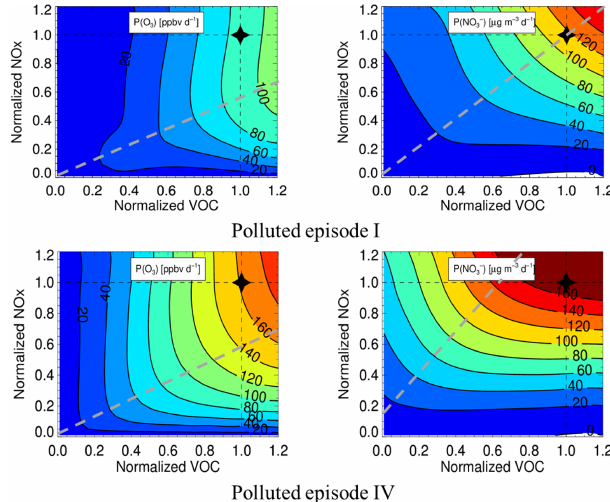
− ) of polluted episodes IV 3